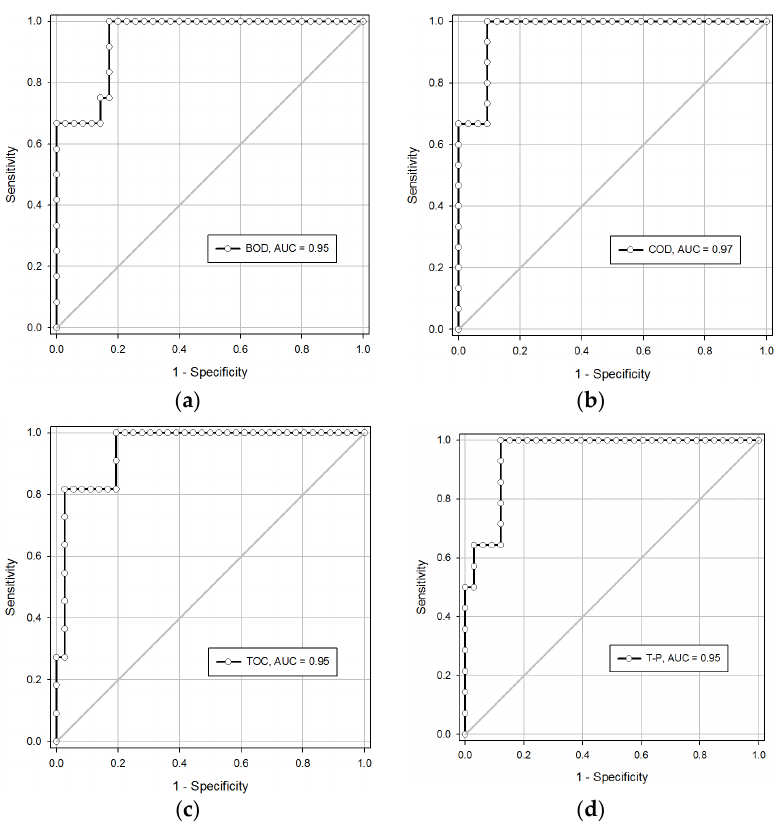
Figure 3 . The results of ROC curve analysis for ( a ) BOD, ( b ) COD, ( c ) TOC, and ( d ) T-P.